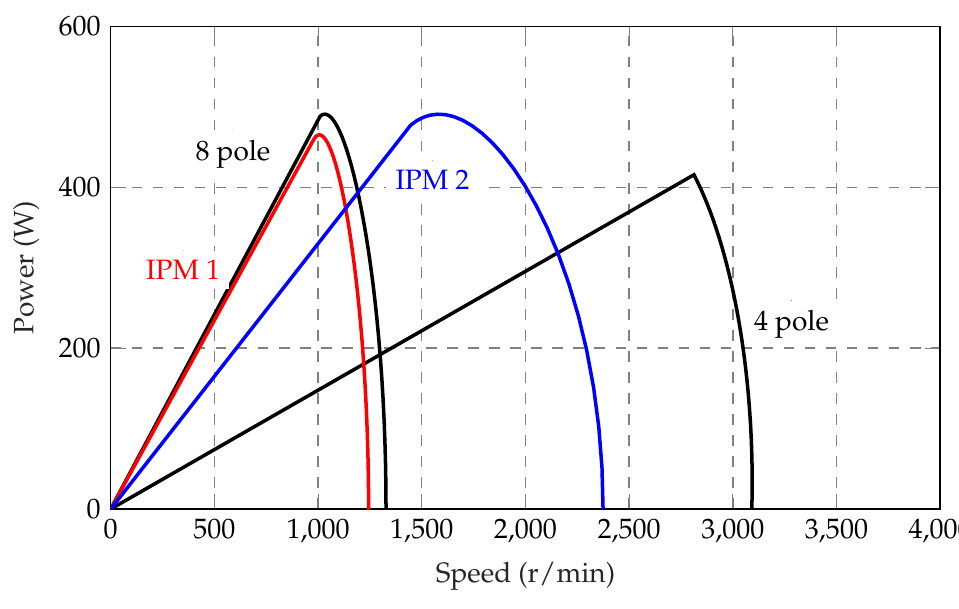
Figure 23. IPM and HE-IPM Torque and Power characteristics comparison.